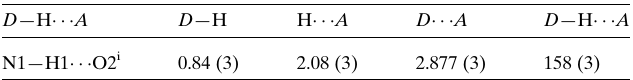
Table 1 Hydrogen-bond geometry (A˚ , (cid:5)